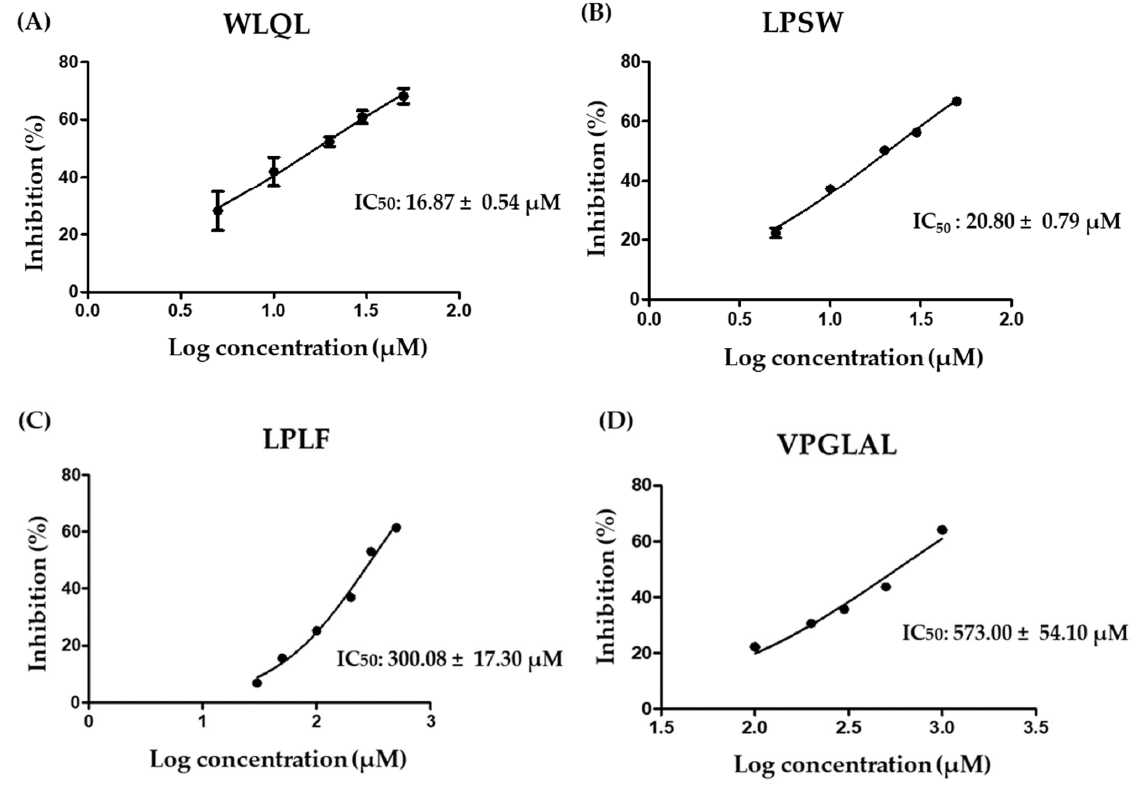
Figure A1. The ACE inhibitory effects of peptides present via the IC 50 values with ( A ) WLQL, ( B ) LPSW, ( C ) LPLF, and ( D ) VPGLAL.